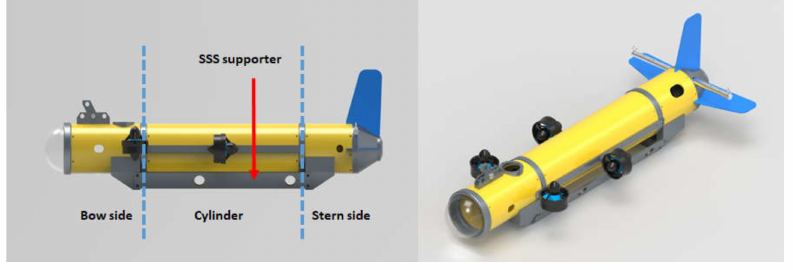
Figure 5. 3D modeling of UUV. SSS, side scan sonar.